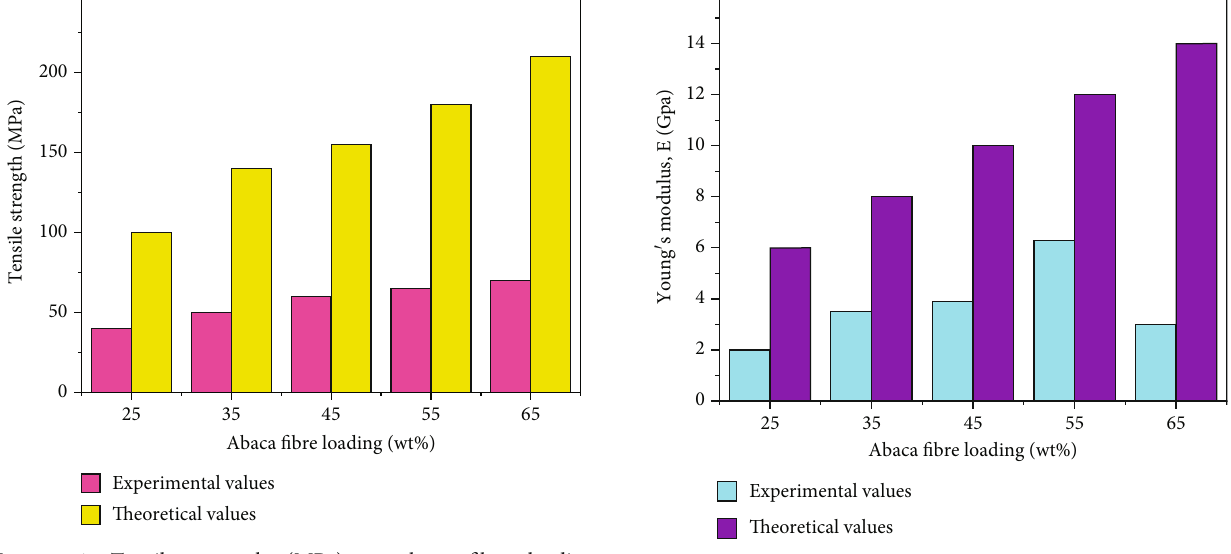
Figure 6: Experimental and theoretical comparison of Young ’ s modulus (GPa) with the loading of the abaca fi bre (wt